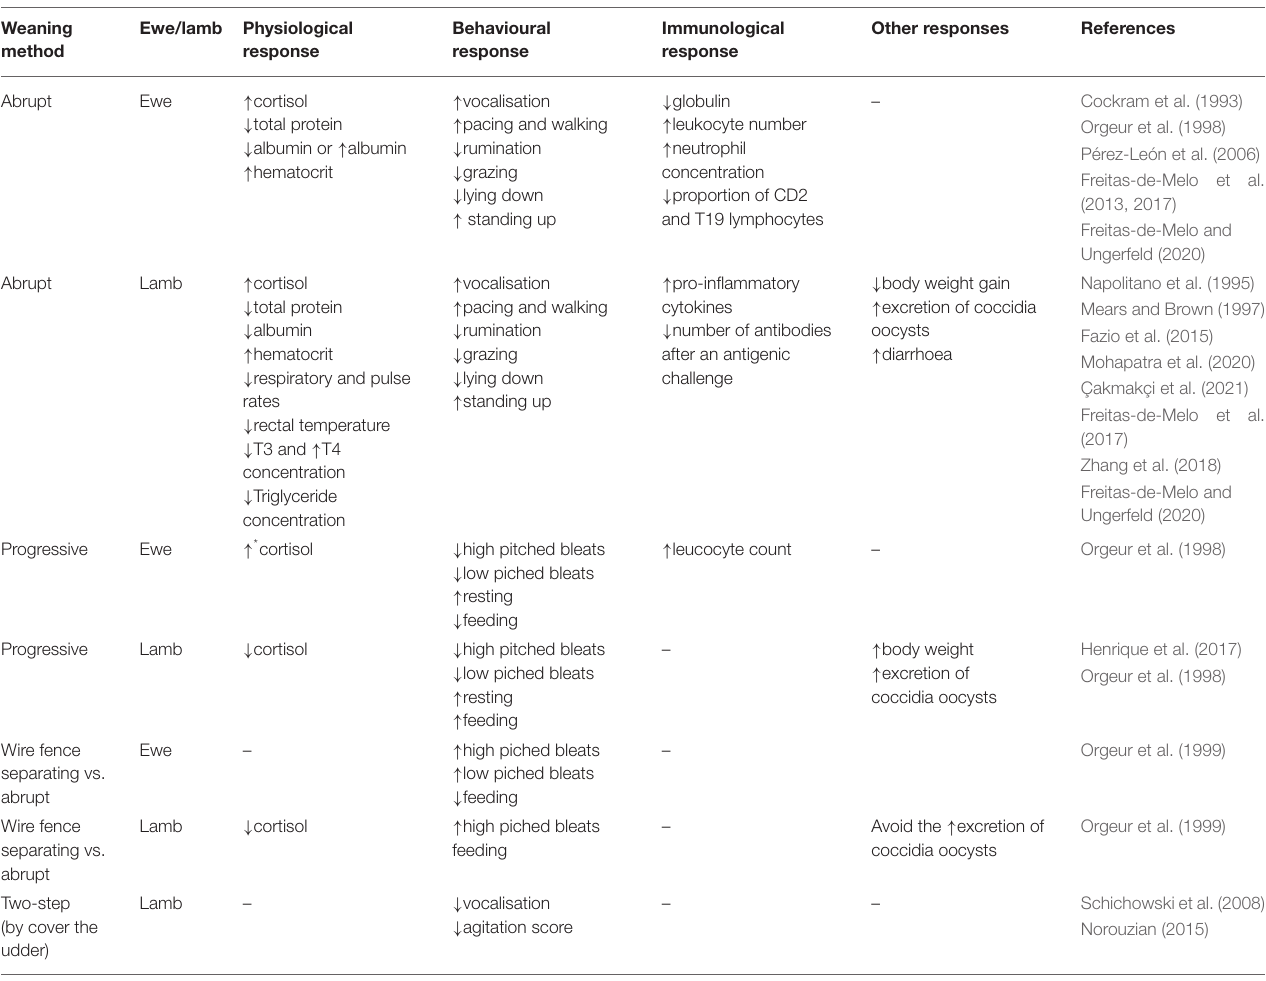
TABLE 3 | Weaning method and physiological, behavioural and immunological responses in lambs and ewes and their consequences in health and growth of lambs after ewe-lamb separation. Weaning